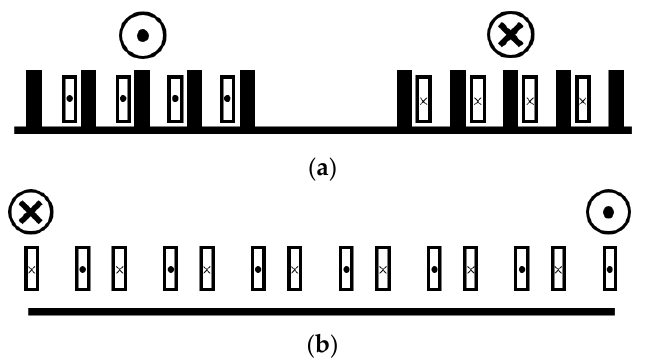
Figure 2. Cross sections of the spiral-type winding method. ( a ) Original model; ( b ) Bifilar method.